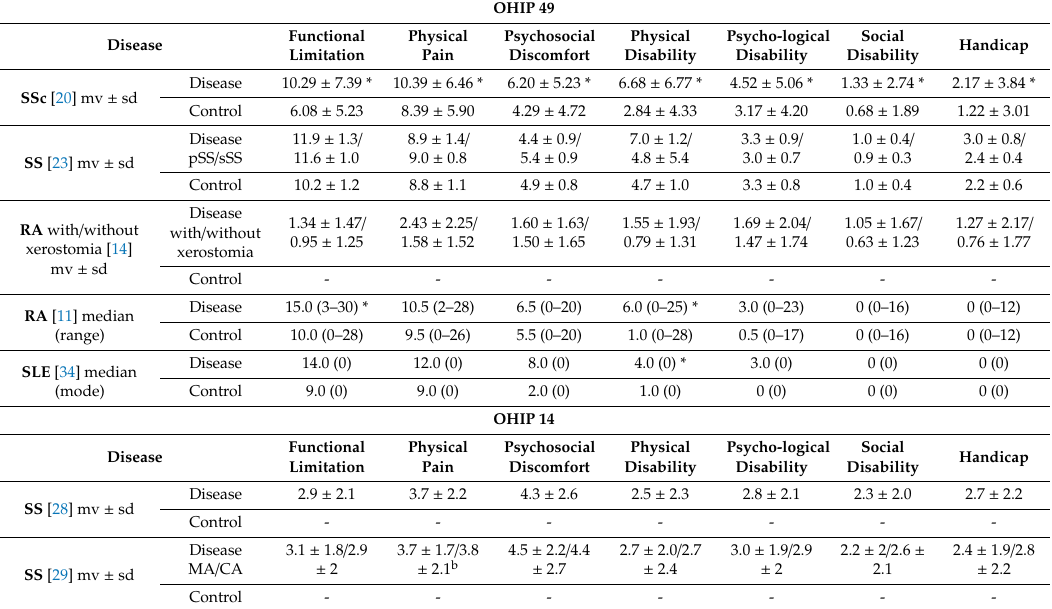
Table 3. Subscales of OHRQoL in included studies with OHIP questionnaire, presenting seven subscales.